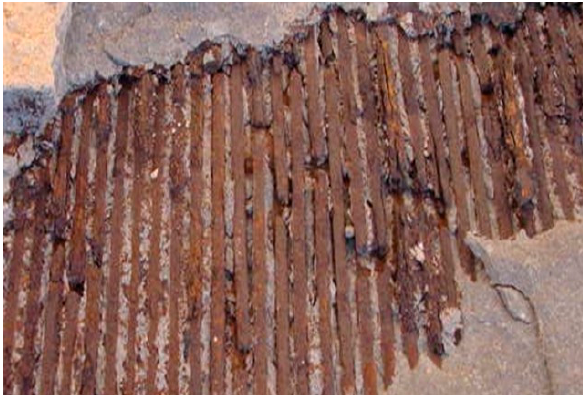
Figure 4. Distressed area of a PCCP.